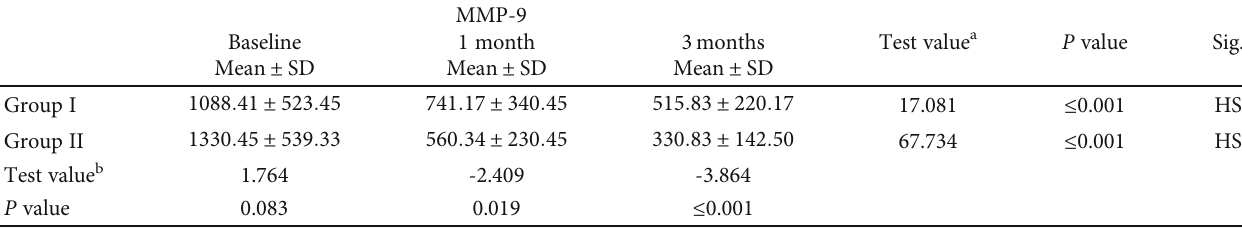
Figure 3: The mean probing depth changes in Group I and Group II. Table 2: The change in mean MMP-9 conc. at di ff erent intervals.